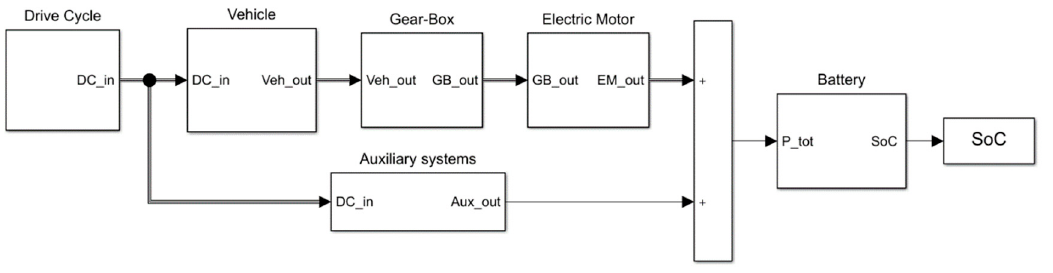
Figure 1. Overview of BQM model of the trolley